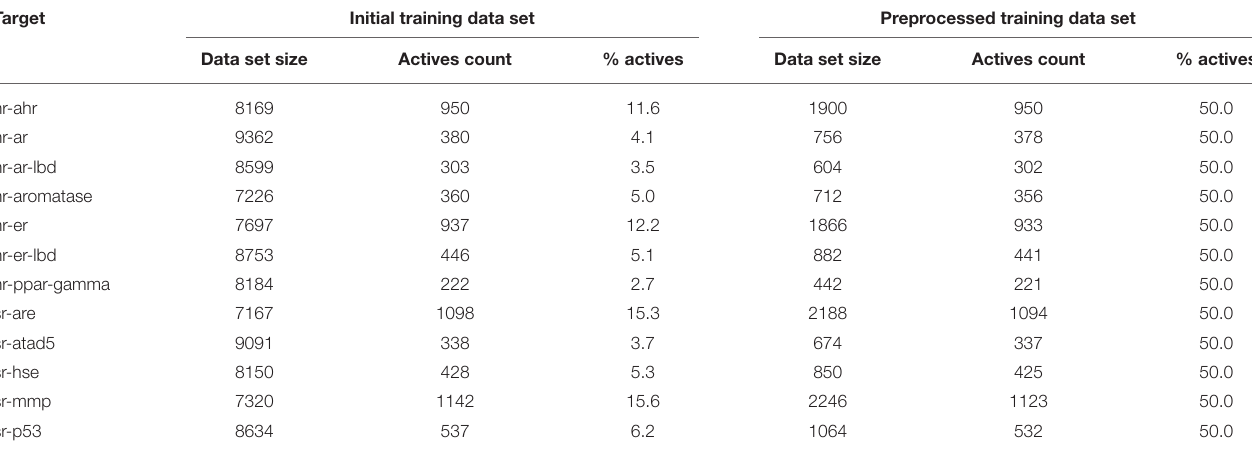
TABLE 2 | Initial and final training data sets